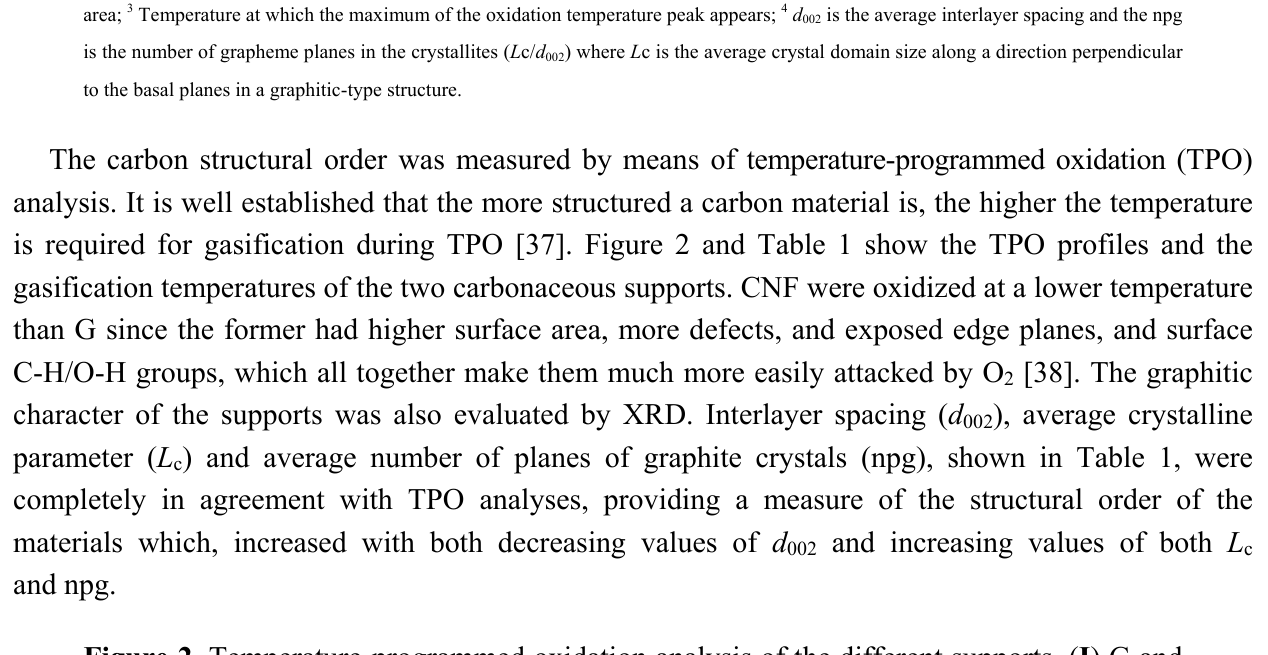
Figure 2. Temperature-programmed oxidation analysis of the different supports, ( I ) G and ( II )